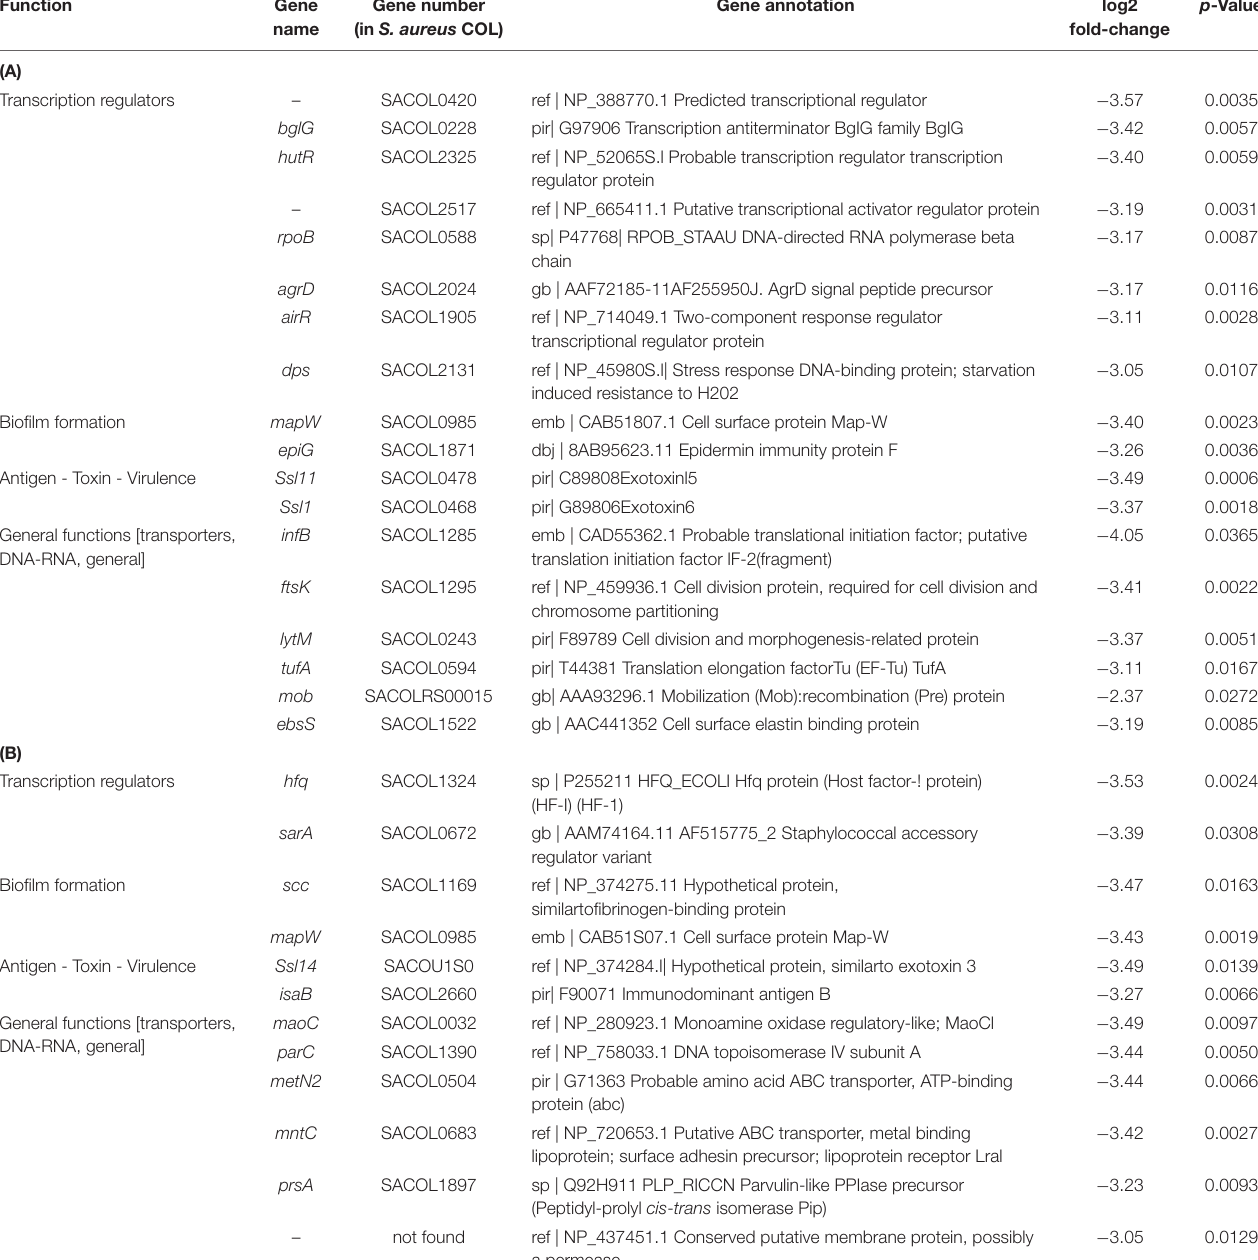
TABLE 4 | Significantly down-regulated genes at pH 5 in S. aureus COL biofilm-associated (A) and planktonic cells (B) ( p < 0.05).